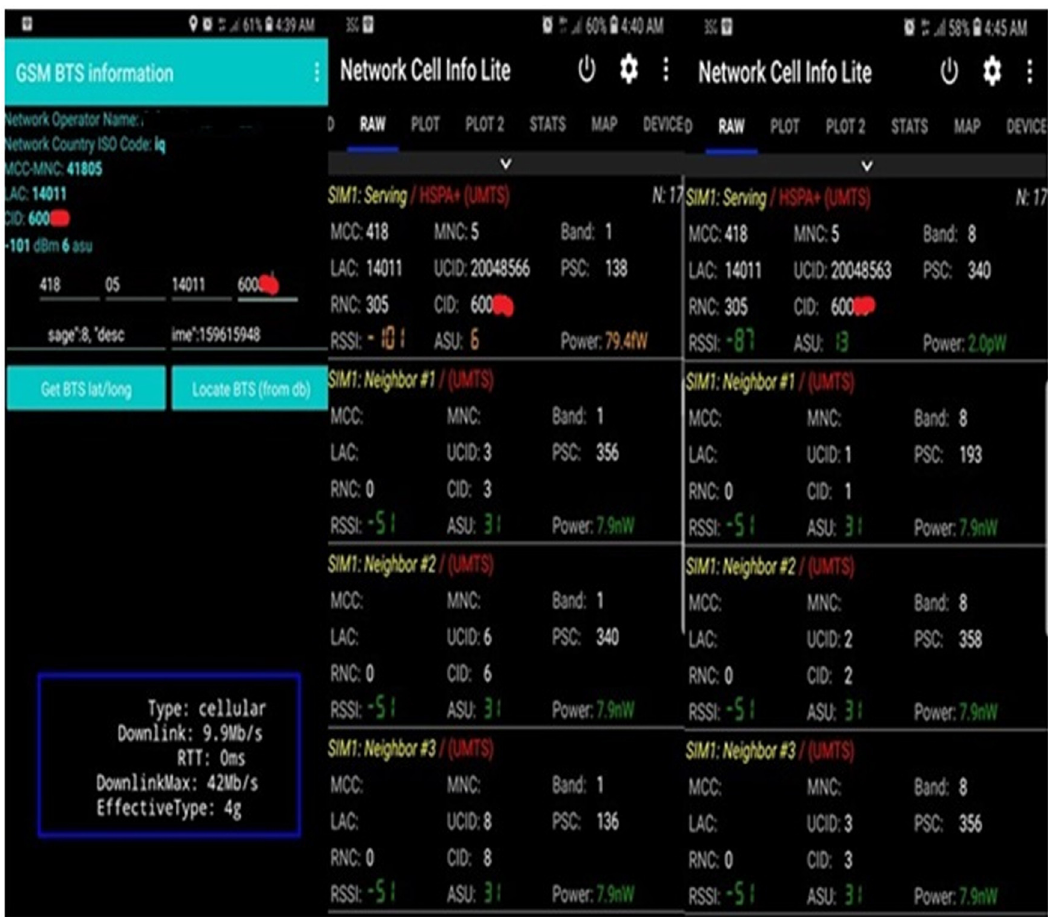
Figure 9: Output mobile network cell info lite and GSM BTS Info applications.